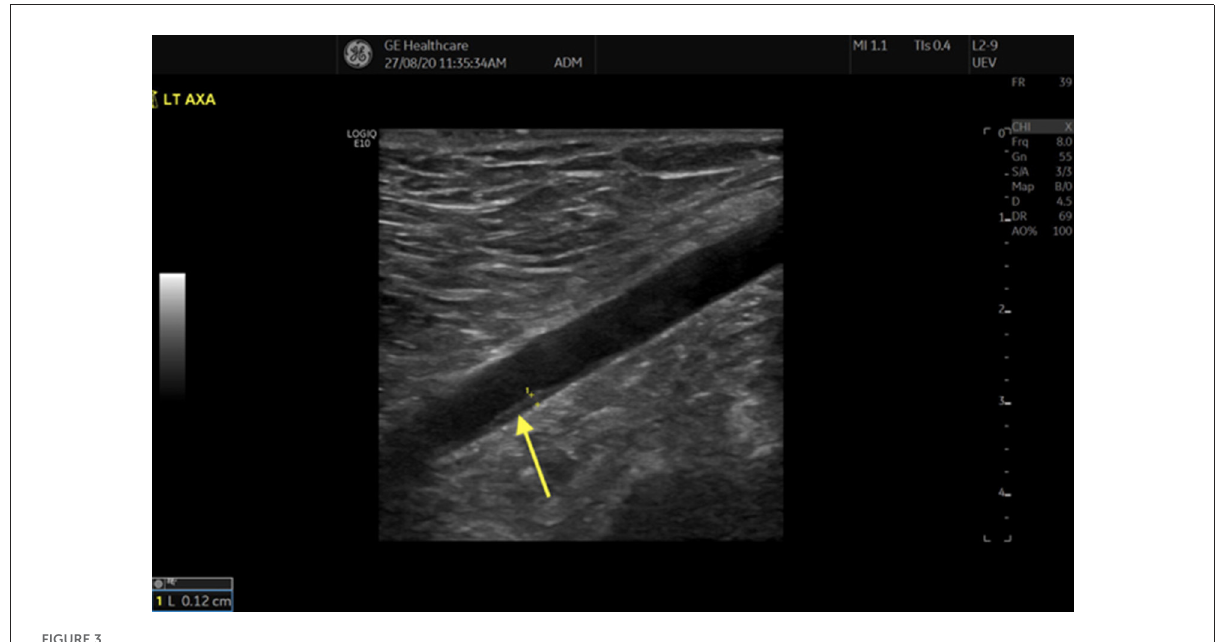
FIGURE3 “Slope” sign in axillary artery vasculitis (yellow arrow).